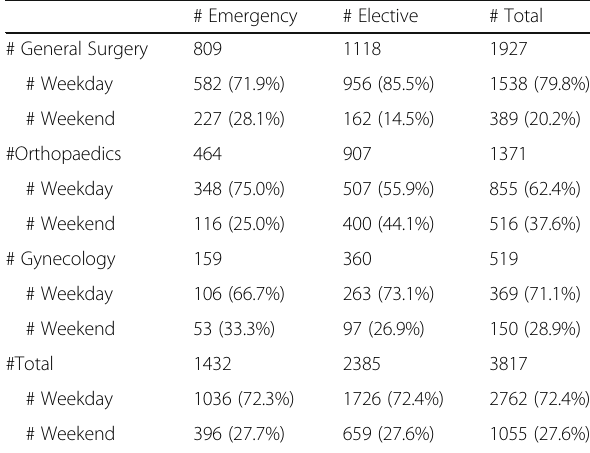
Table 1 Total recorded case volume in 2018 (361